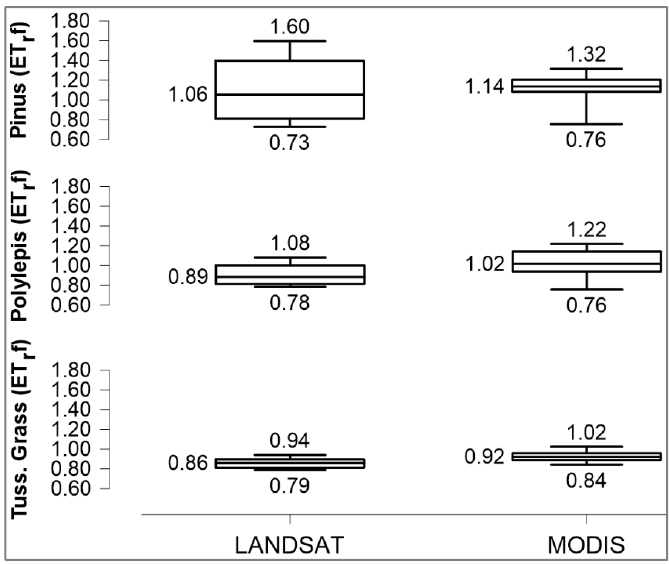
Figure 4. Reference ET fraction ( ET r f ) for METRIC L and METRIC M for the vegetated testing plots in the study area (median, minimum and maximum).